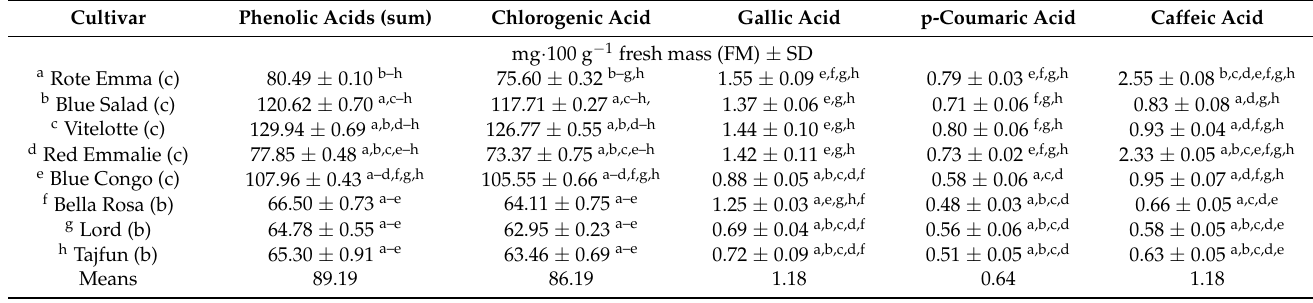
Table 2. Phenolic acid content in coloured and bright-fleshed potato tubers (mg 100 g − 1